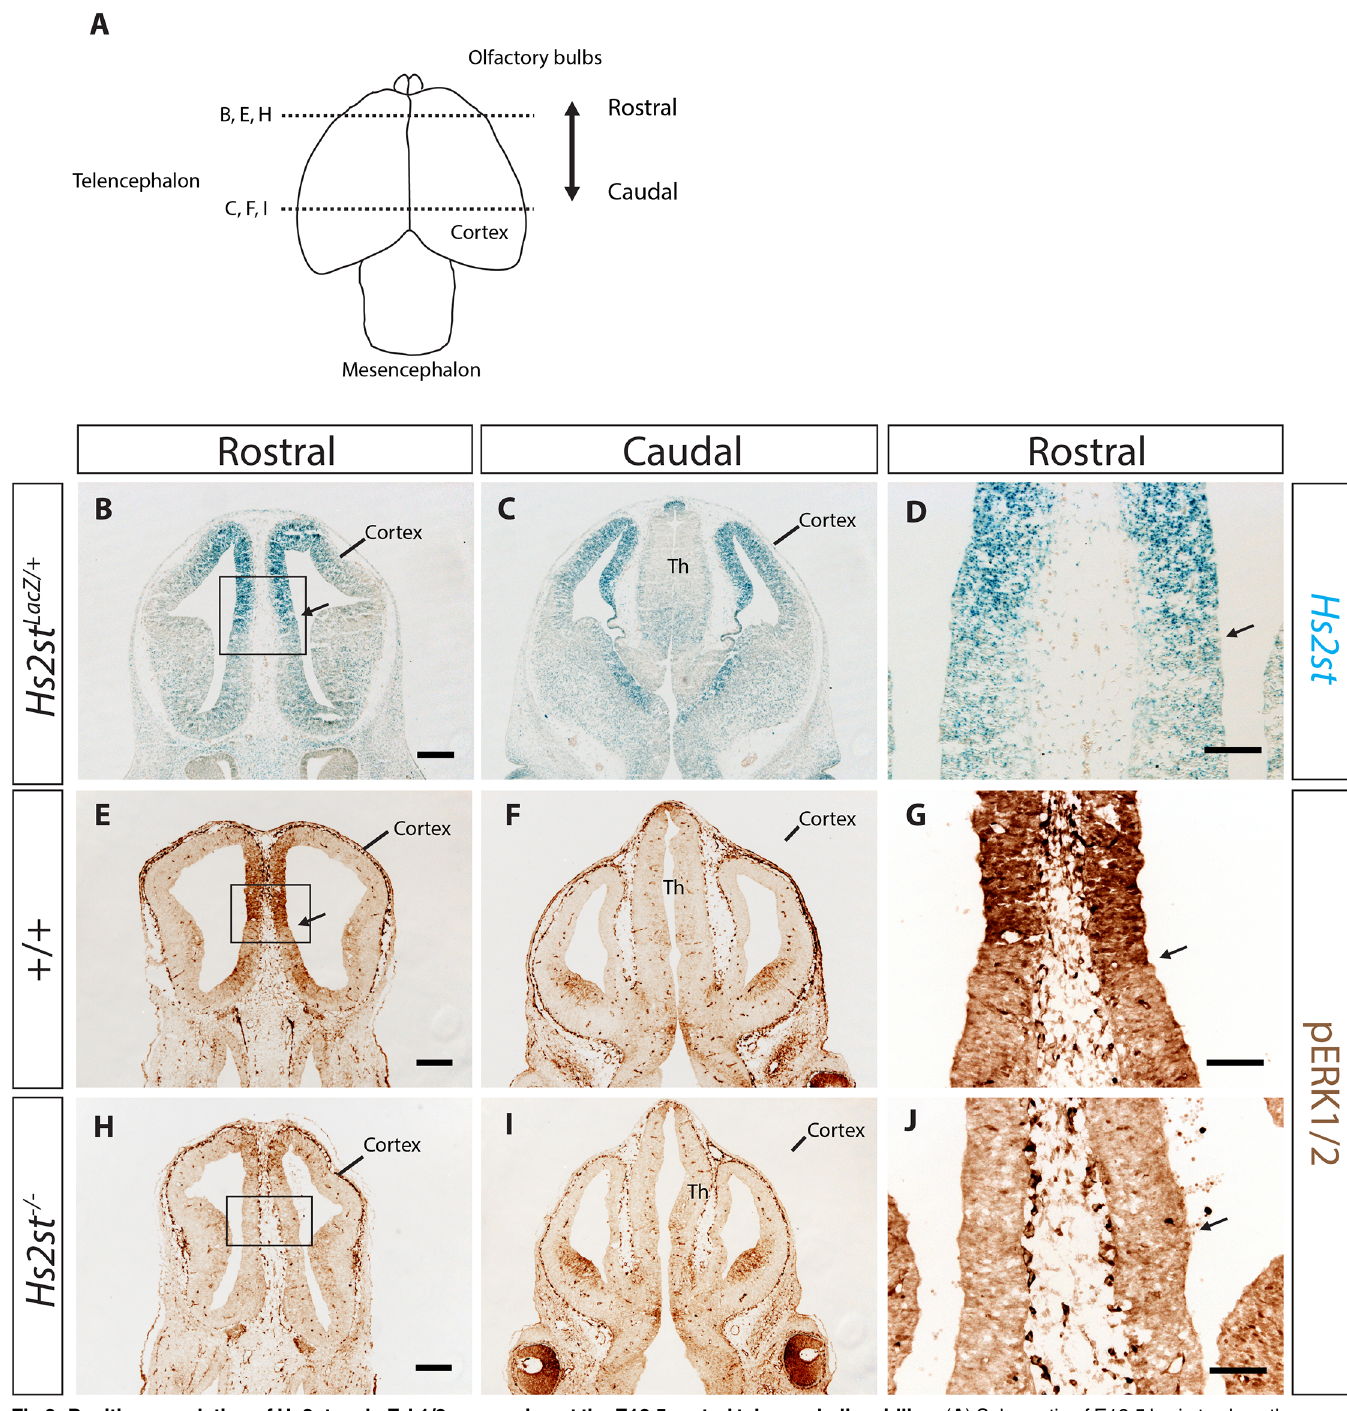
Fig 2. Positive correlation of Hs2st and pErk1/2 expression at the E12.5 rostral telencephalic midline. ( A ) Schematic of E12.5 brain to show the positions of coronal sections in ( B – J ). ( B – D ) Hs2st (blue LacZ stain) is expressed throughout the telencephalon with highest expression in the dorsal telencephalon and a clear medial high -lateral low gradient (n = 3). ( D ) shows higher magnification of black box in ( B ). Black arrow in ( B and D ) show distinct border at dorsal high -ventral low Hs2st expression boundary. ( E – G ) shows expression of pErk1/2 in wild-type telencephalon indicated by brown DAB staining (n = 5). ( E ) pErk1/2 was highly expressed in the midline. There is a distinct border between dorsal midline which has high expression of pErk1/2 and ventral midline which has low expression of pErk1/2. ( G ) is a higher magnification of black box in ( E ). Black arrows in ( E ) and ( G ) shows distinct border at dorsal high - ventral low pErk1/2 expression boundary. ( F ) pErk1/2 was not highly expressed in the caudal telencephalon compared to the rostral telencephalon.